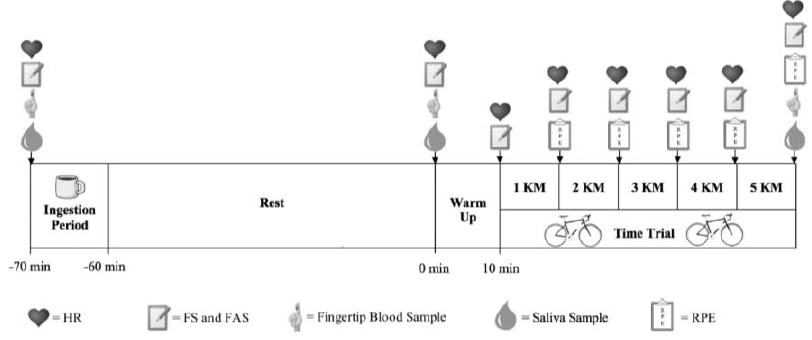
Figure 1. Schematic of the exercise protocol.